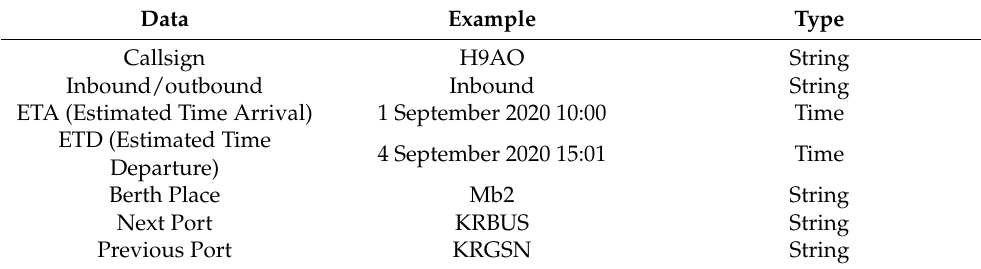
Table 3. Port MIS data.